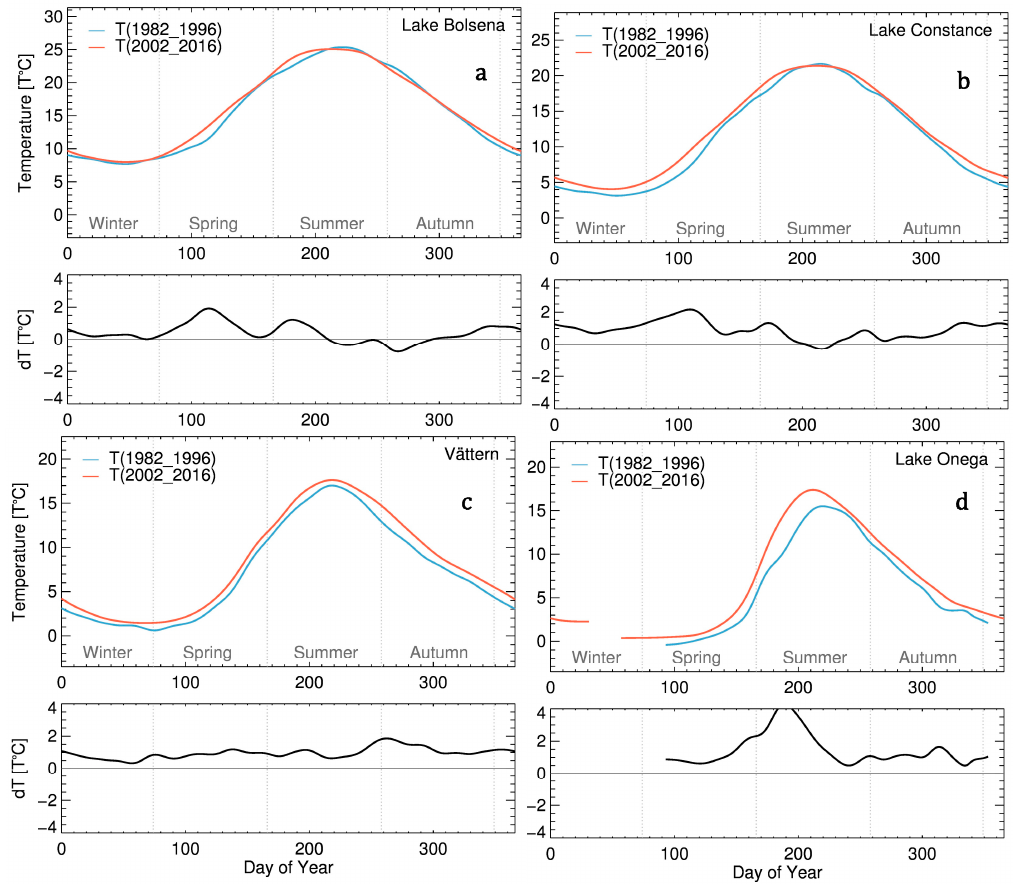
Figure 14. Comparison of the Yearly Temperature Cycle from two different 15-years-periods at Lake Bolsena ( a ), Lake Constance ( b ), Lake Vättern ( c ), and Lake Onega ( d ). The red and the blue lines represent the yearly cycle of the two periods; the black line is the difference between the two periods.